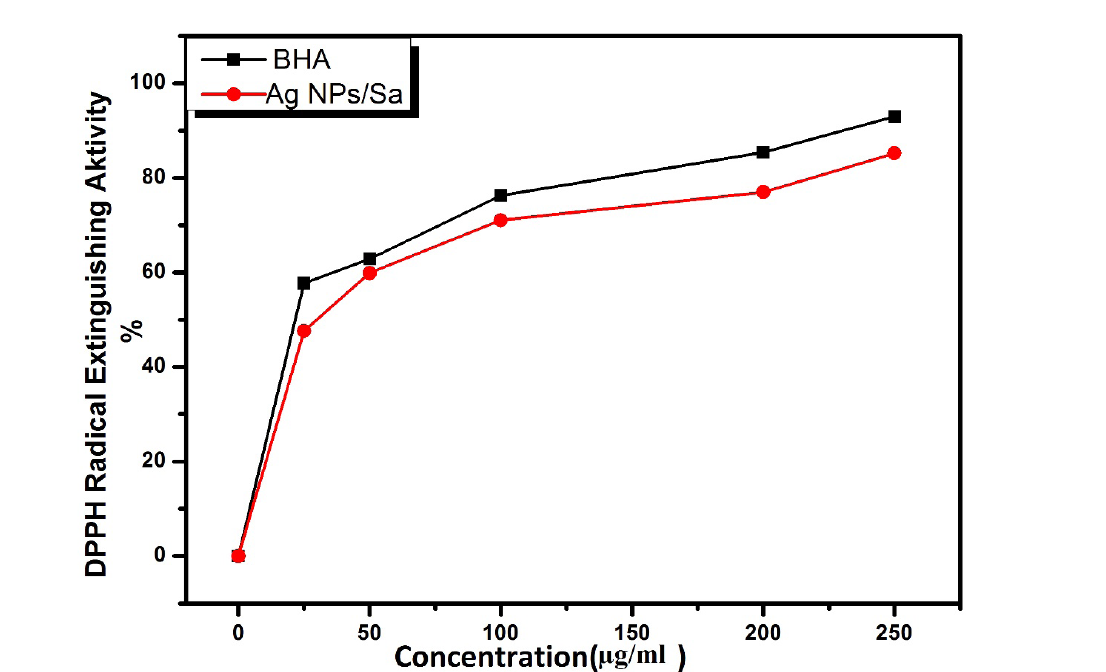
FIGURE 5 - DPPH radical scavenging activity of the ethanol extract of S. alopecuroides L. green synthesized of Ag